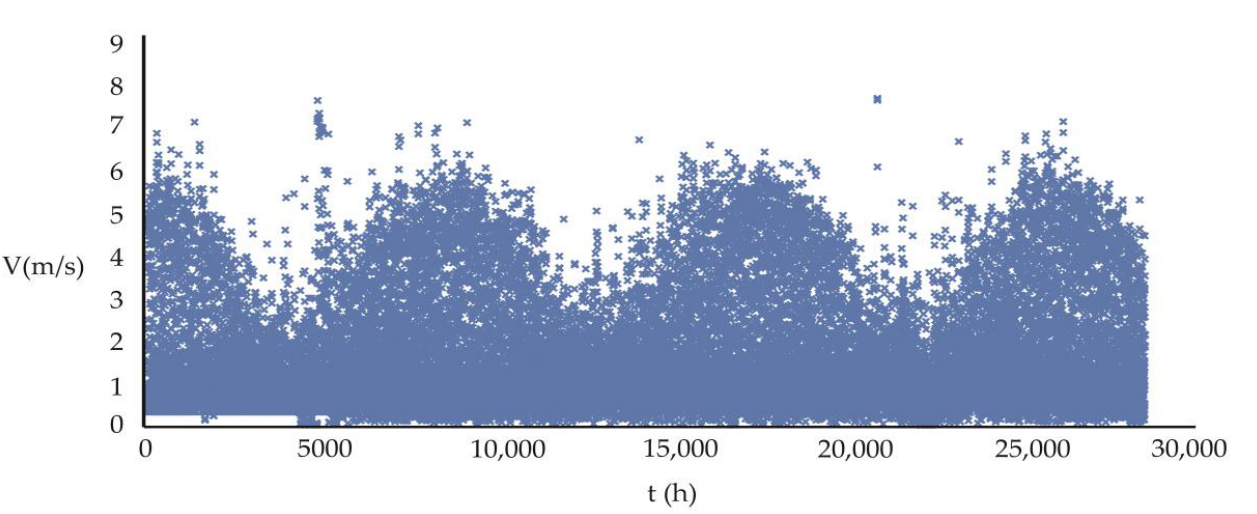
Figure 1. Distribution of the 28,463 hourly wind speed (WS) magnitudes for the period 2010 – 2013 for the Puente Alto commune. The Figure is similar for the other five communes in the study.